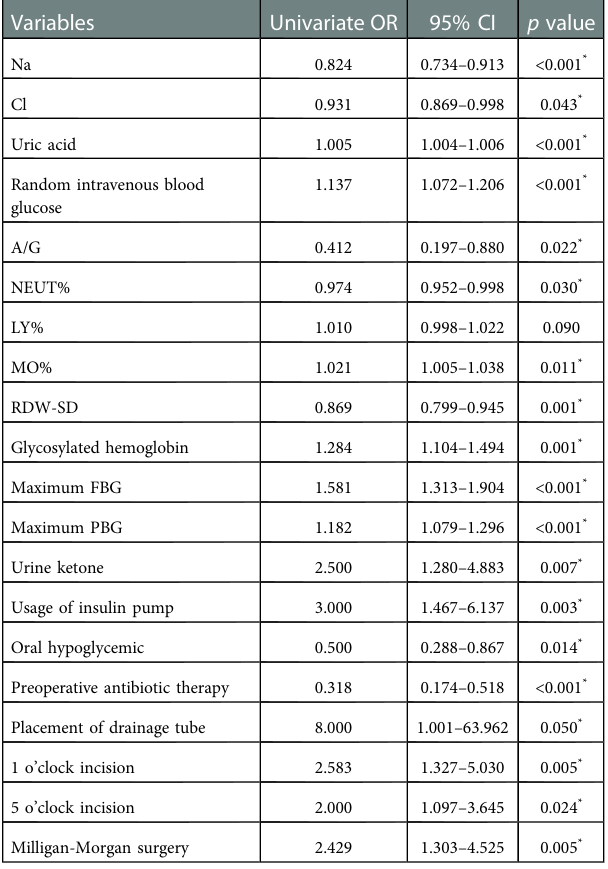
TABLE 5 Univariate regression analysis for relevant